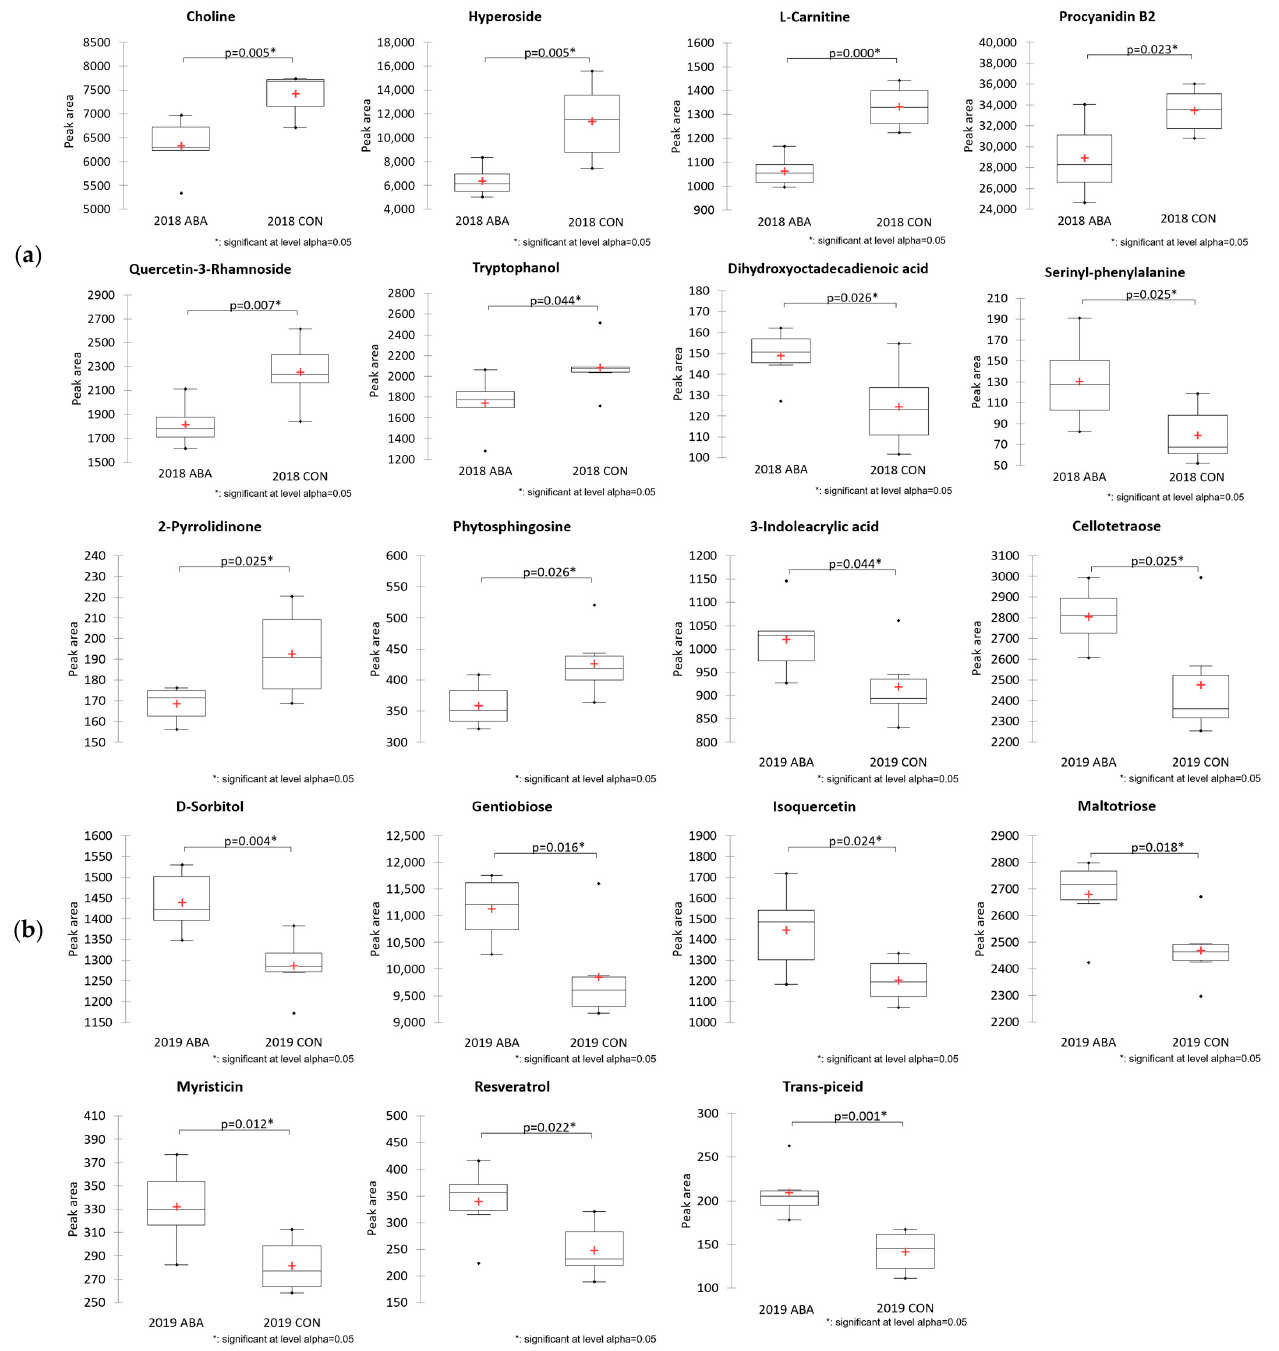
Figure 5. Boxplots of the tentatively annotated metabolites that differed statistically ( p < 0.05) in wines from GRBV-positive Pinot noir treated with exogenous abscisic acid application (ABA) and no abscisic acid control (CON) for two years (( a ): 2018; ( b ): 2019). Y -axis shows the relative abundance (peak area) of the compound. The box represents the 25% and 75% percentiles. The middle line of the box indicates the median and the red cross expresses the mean of the data. The short lines above and below the box represent the maximum and minimum points. Black dots on the two ends of the box represent single data. Two-sample t -tests were conducted for p -value calculation.